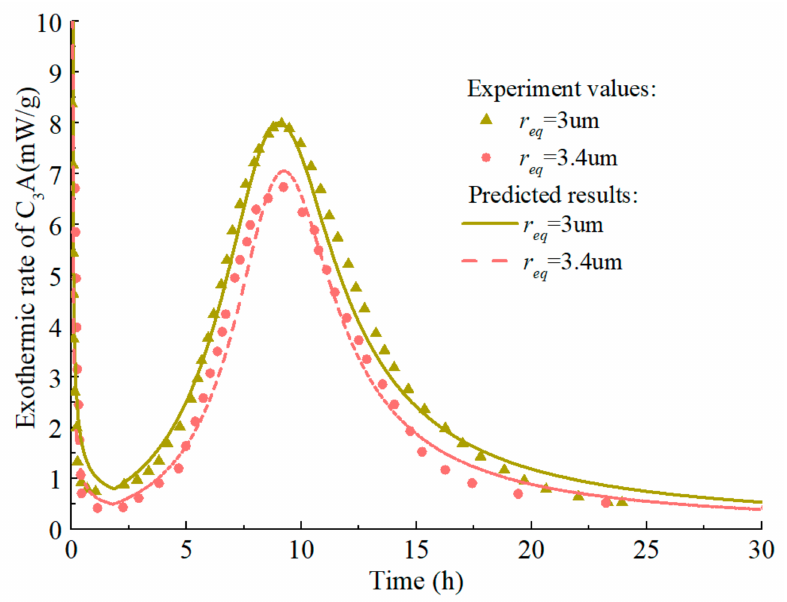
Figure 8. Isothermal calorimetry test values and prediction curves of pure C 3 S in early age.